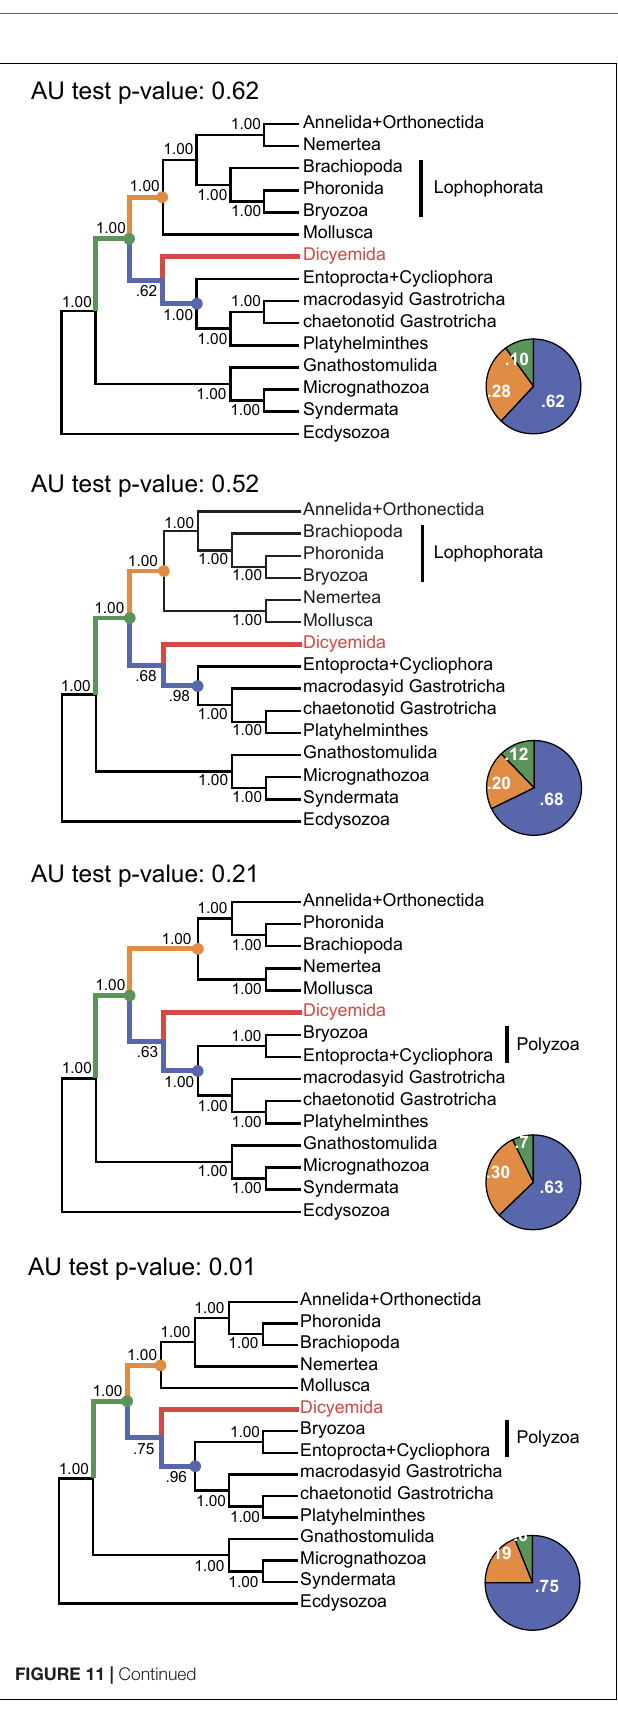
FIGURE 11 | Tree topologies in the four chains of the PhyloBayes run. Each panel summarizes the topology obtained in a single chain of the analysis. The monophyly of almost all clades and all major spiralian phyla receives posterior probability of 1.0 in each chain (even if they differ between the chains). In contrast, the position of the dicyemid lineage receives moderate support in each chain. The pie charts reflect the portion of trees where the dicyemid lineage occupies one of the three observed positions in the cunsensus (represented with color). Topologies in each chain were compared with the approximately unbiased (AU) test using the “sitelogl” option of the PhyloBayes; AU test p -values are shown above each topology.